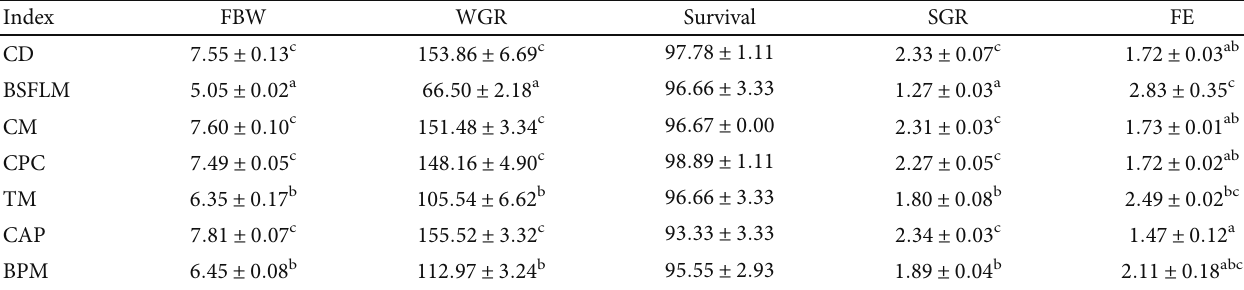
Data represent mean ± SEM of three replicates ( n = 3 ). Values in the same line with di ff erent letters are signi fi cantly di ff erent ( P < 0 : 05 ) based on Duncan ’ s test. The lack of superscript letter indicates no signi fi cant di ff erences among groups. FBW: fi nal body weight (g); WGR: weight gain rate (%); SGR: speci fi c growth rate (% day -1 ); FE: feed e ffi ciency; CD: control diet; BSFLM: black soldier fl y larvae meal; CM: Chlorella vulgaris meal; CPC: cottonseed protein concentrate; TM: Tenebrio molitor meal; CAP: Clostridium autoethanogenum protein; BPM: methanotroph bacterial meal. Table 5: Apparent digestibility coe ffi cients for dry matter of diets and ingredients, crude protein, crude lipid, and phosphorus (%) of test ingredients in Litopenaeus vannamei.